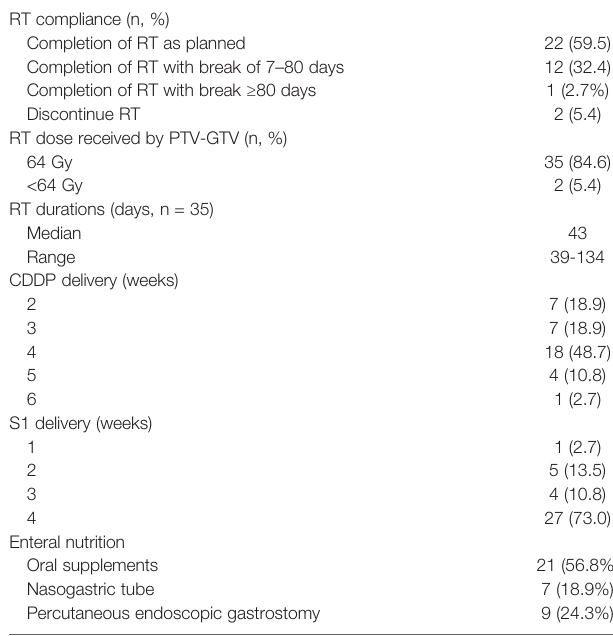
TABLE 1 | Baseline characteristics (n = 37). TABLE 2 | Treatment compliance (n = 37).